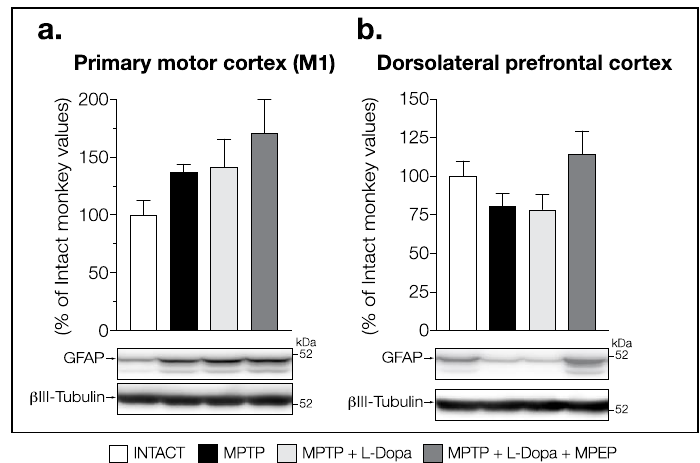
Figure 5. Western blots for GFAP protein levels in ( a ) primary motor cortex (M1) and ( b ) dorsolateral prefrontal cortex (PFCd) of intact monkeys (control), MPTP monkeys treated with saline, L- Dopa, and L-Dopa + MPEP. Values are means of arbitrary units expressed as percentage of control (βIII -tubulin was used as internal loading control) of 4–6 independent experiments ± standard error of mean of 4–5 monkeys per group.